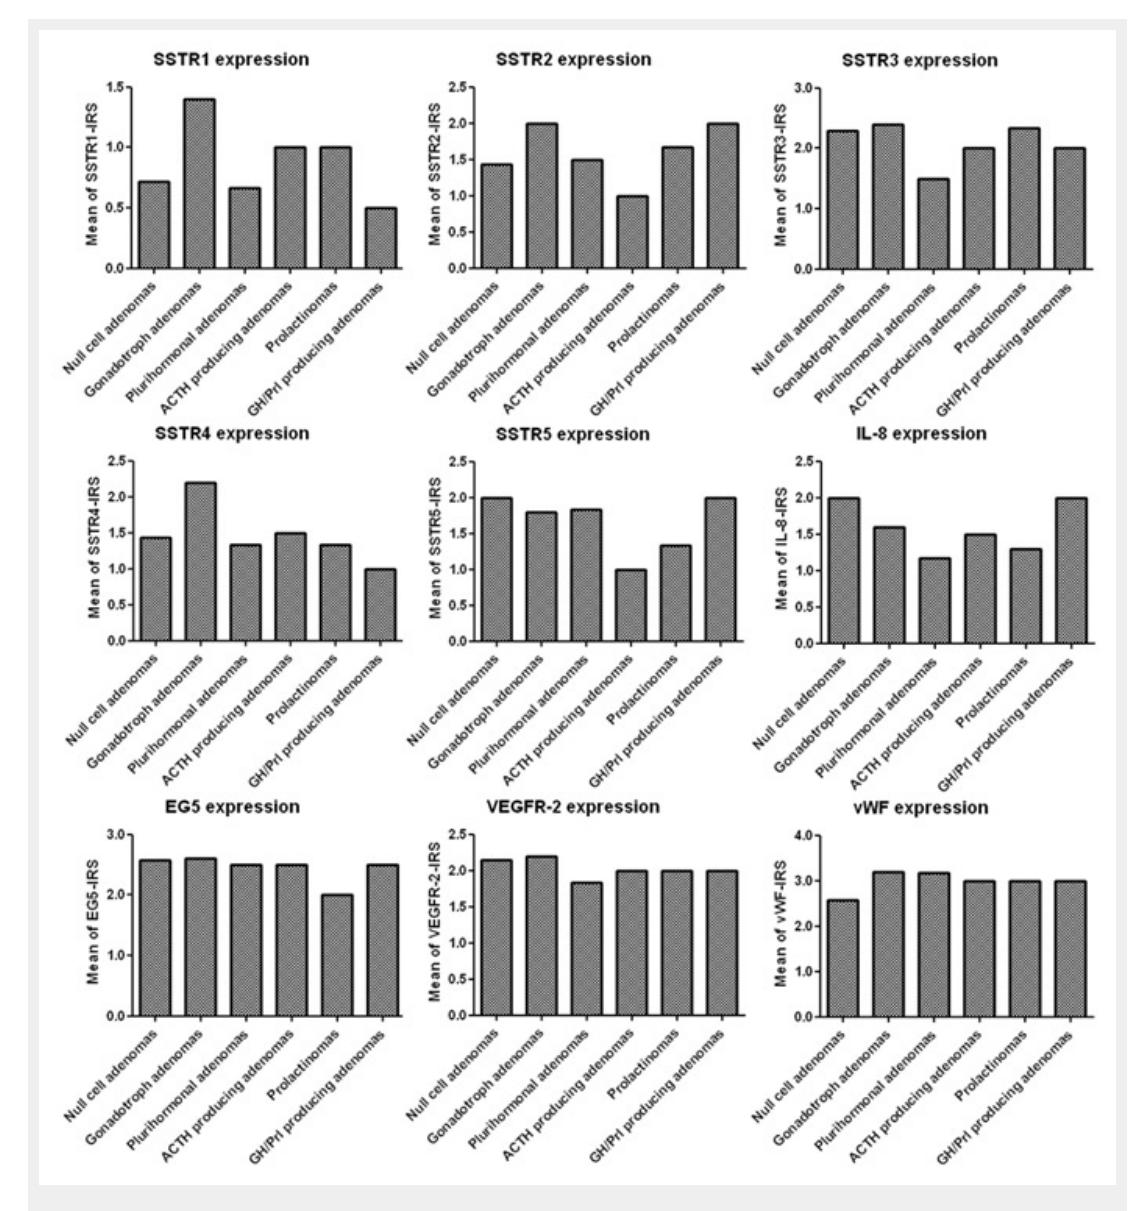
Figure 4 SSTR-, IL8-, Eg5-, VEGFR-2- and vWF-expression of the different pituitary adenoma subtypes. Note that the y-axes represent the mean immunoreactivity score. ACTH = adrenocorticotrophic hormone; Eg5 = kinesin spindle protein; GH = growth hormone; IL-8 = interleukin-8; Prl = prolactin; SSTR = somatostatin receptor; VEGFR-2 = vascular endothelial growth facto receptorr-2; vWF = von